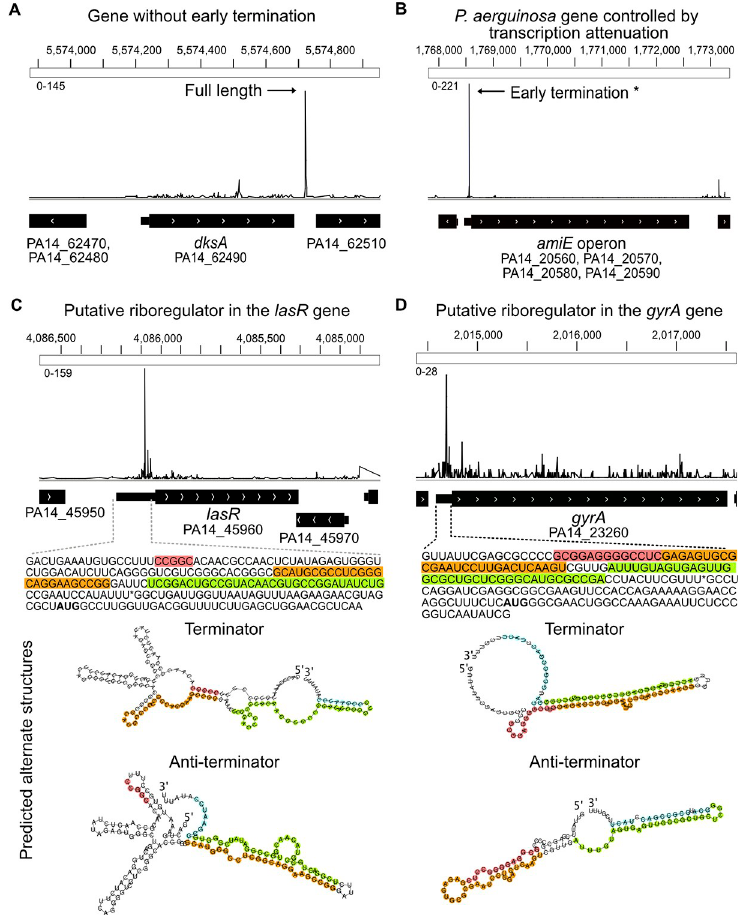
Fig 4. Predicting genes regulated by premature 3’ end formation in transcript leaders. IGV views show strand- specific 3’ end counts. (A) Example of a gene ( dksA PA14_62490) not predicted to be regulated by premature transcription termination in its transcript leader. The major 3’ end peak is in the 3’ UTR. (B) IGV view of early termination in the amiE operon, known to be regulated by transcription attenuation, shows major 3’ end peak in transcript leader. (C) IGV view of lasR shows premature 3’ end peaks in its transcript leader. The sequence of the lasR early termination region and predicted alternate secondary structures in the transcript leader are shown below. The asterisk denotes a premature 3’ end peak. Alternate structures with potential to effect early termination (terminator and transcriptional read-through (anti-terminator was predicted with PASIFIC [68] using the sequence upstream of the asterisk (corresponding to a 3’ end significant peak) as the input. (D) IGV view of DNA gyrase A ( gyrA) shows premature 3’ ends in its transcript leader. The sequence of gyrA transcript leader and 40 nt in the CDS and the alternate structures predicted by PASIFIC are shown below, as in